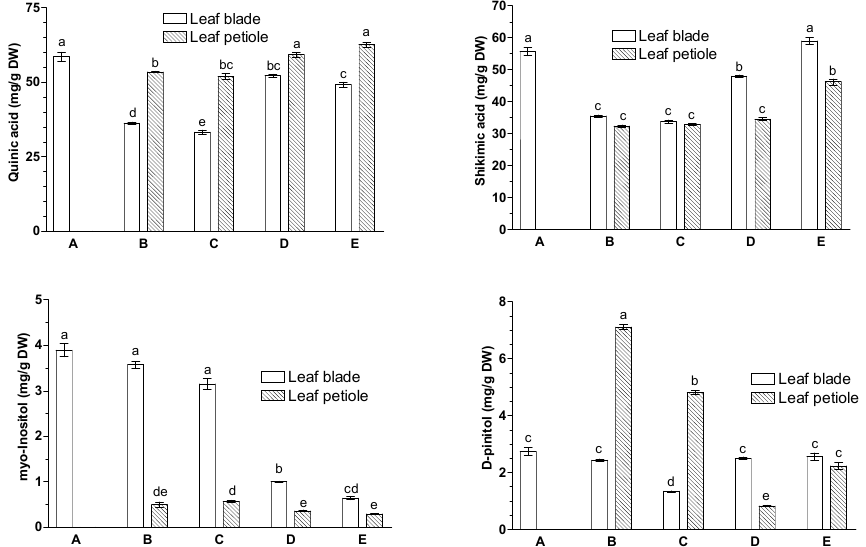
Figure 4. Effects of methyl jasmonate (JA-Me) applied to the adaxial and abaxial sides of the leaf blade on the contents (mg/g DW) of cyclohexitols in leaf blades and petioles of G. biloba . Mean results ± SD followed by the same letter were not significantly different ( p < 0.05) according to Tukey’s test. A—initial stage, leaf samples collected on 9 September; B—control (lanoline), leaf samples collected on 30 September; C—JA-Me applied to the adaxial side, leaf samples collected on 30 September; D—JA-Me applied to the abaxial side, leaf samples collected on 30 September; E—naturally senesced leaf, samples collected on 20 October Quinic acid and shikimic acid are key intermediates in the biosynthesis of aromatic